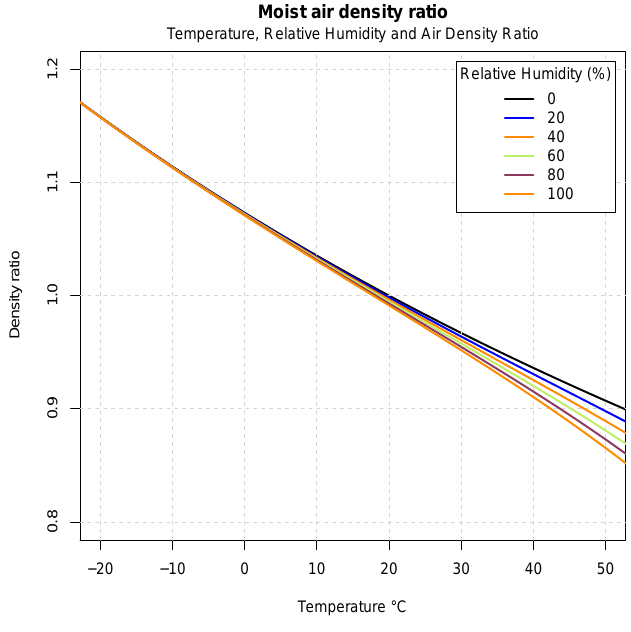
Figure 1. Moist air density ratio versus temperature and relative